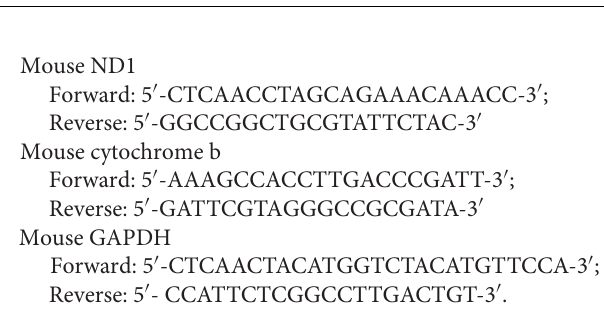
FIGURE 1 | Experimental protocol